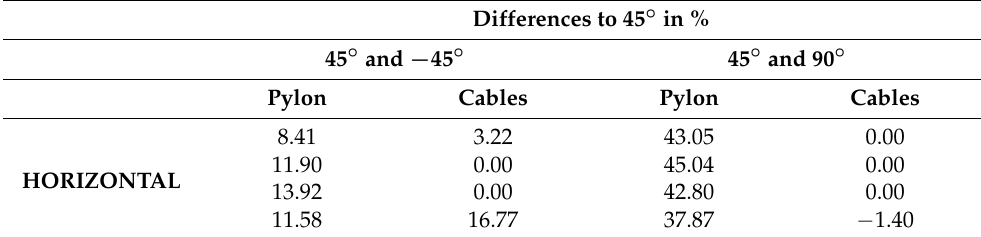
Table 9. Sensibility analysis of the influence of the angle to the 45 ◦